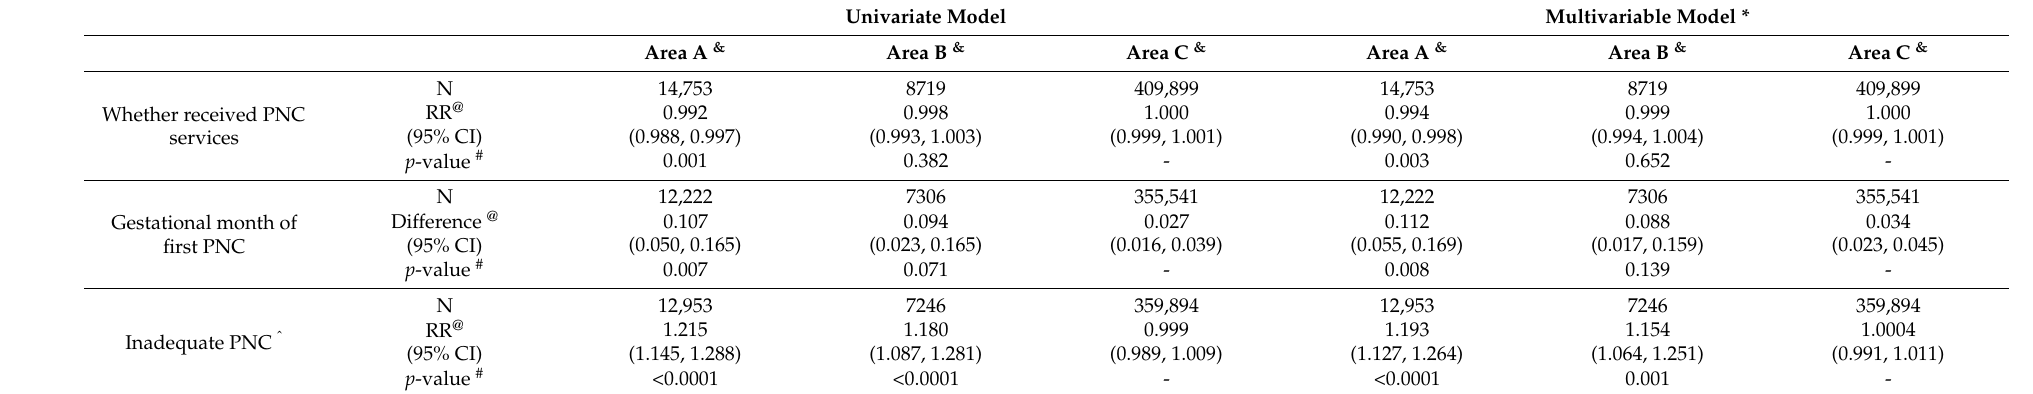
Table 2. Changes in prenatal care use before after Hurricane Michael among different areas.